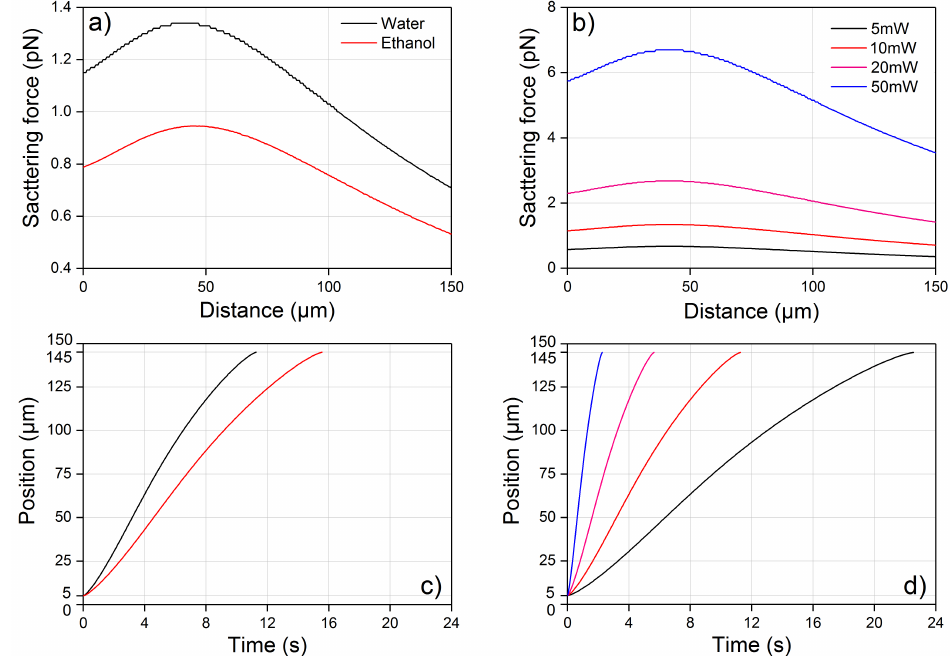
Figure 5. Theoretical calculations of the F S , TOT profile exerted on a poly(methyl methacrylate) (PMMA) bead of 10 µm diameter and of its corresponding optical shooting trajectory from the left laser beam only. ( a ) F S , TOT along the laser beam axis, and across the full channel width, is calculated for both water and ethanol at the same laser power of 10 mW; ( b ) F S , TOT in water, calculated for different laser powers; ( c , d ) are the optical shooting trajectories corresponding to the optical force profile in ( a , b ),